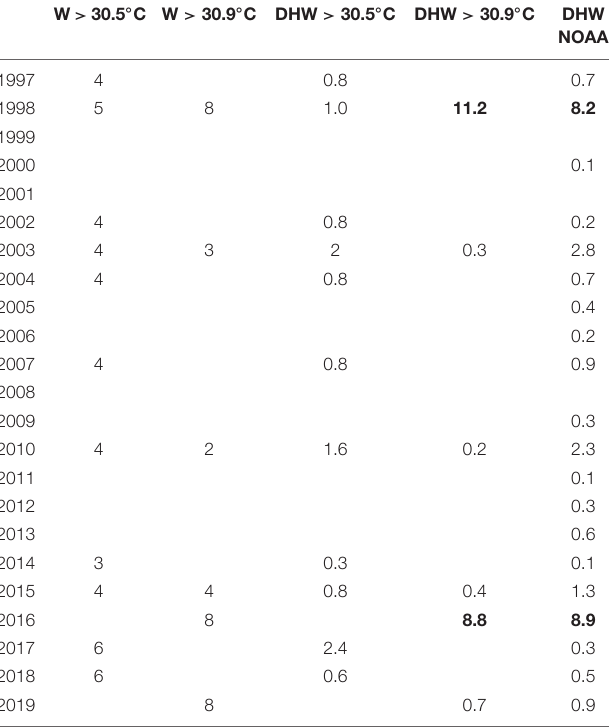
TABLE 1 | Number of weeks (W) per year when the monthly mean sea surface temperature (SST) was higher than the temperatures triggering moderate (30.5 ◦ C) and severe (30.9 ◦ C) bleaching; degree heating weeks (DHW) above the moderate (30.5 ◦ C) and severe (30.9 ◦ C) bleaching thresholds per year as estimated from the monthly SST for the Maldives and DHW values reported in the NOAA coral reef watch database from the region “northern-eastern hemisphere centre” (i.e., central Indian Ocean) over an area of 60 degrees × 40 degrees (available at